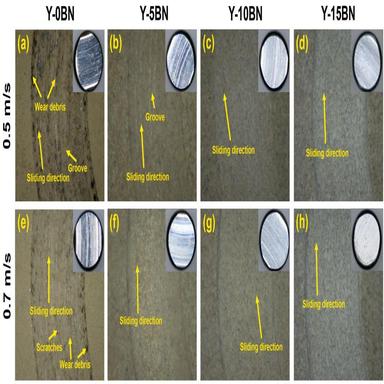
Optical morphologies of wear tracks of the coatings and counterparts under different linear speeds: 0.5 m/s (a–d) and 0.7 m/s (e–h).